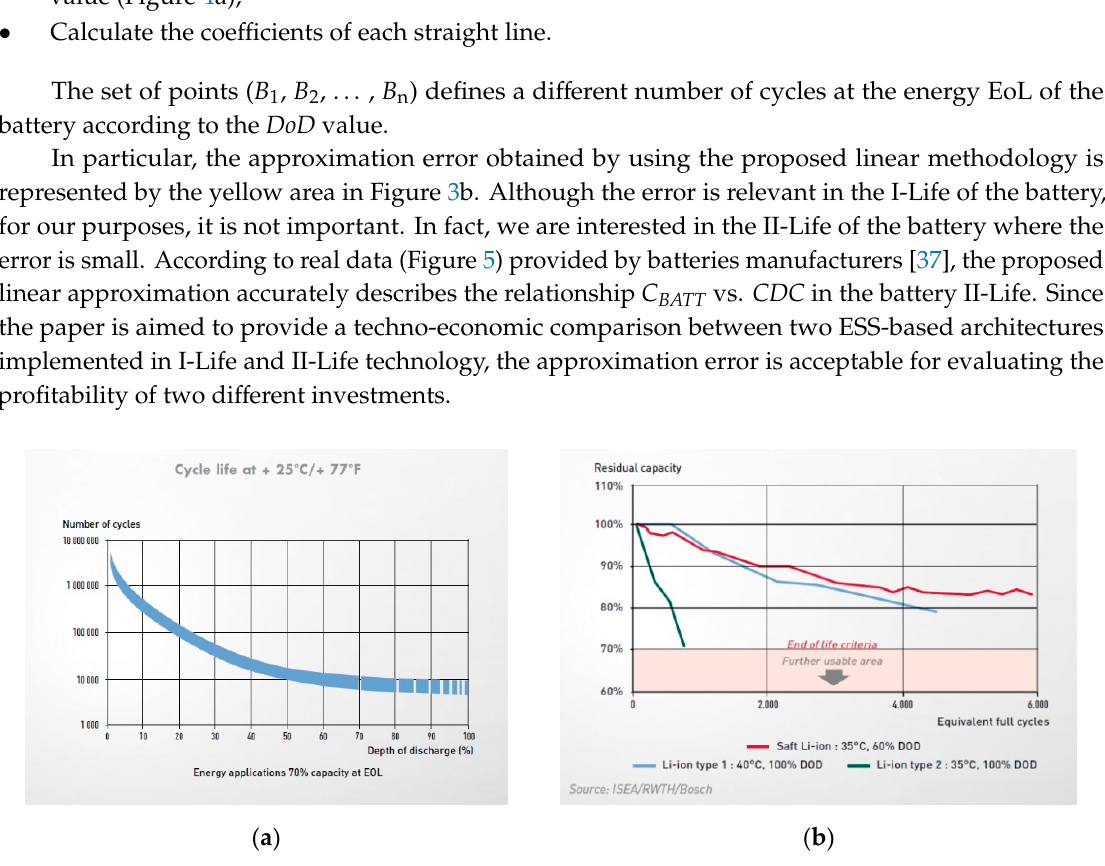
Figure 5. SAFT manufactured lithium-ion batteries: ( a ) Maximum number of CDC vs. DoD trend; ( b ) Residual capacity vs. CDC trend.